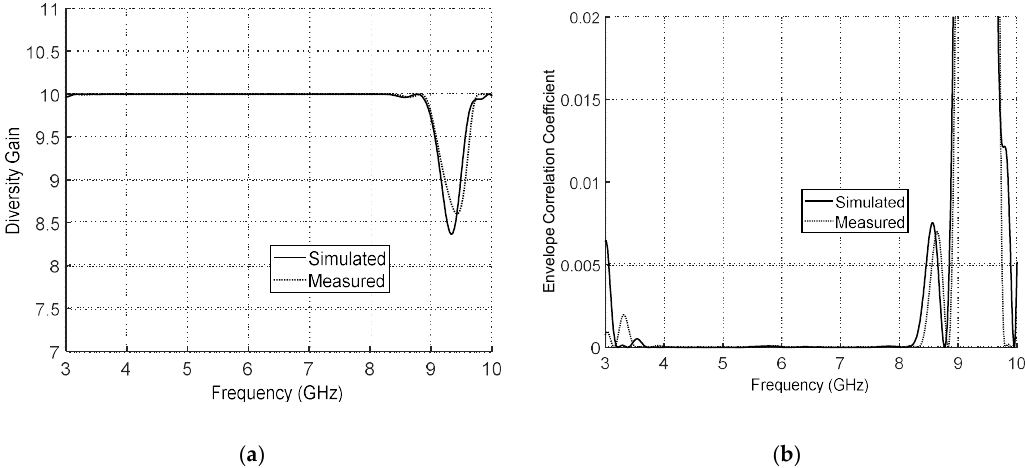
Figure 17. MIMO performance. ( a ) Diversity gain and ( b ) envelope correlation coefficient.